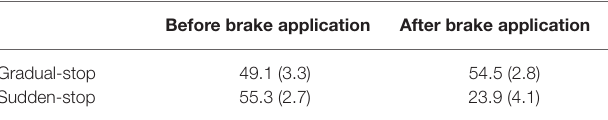
TABLE 2 | Mean SoA ratings as a function of keypress timing (before and after brake application) and type of stop on automatic control trials in the goal-present condition.